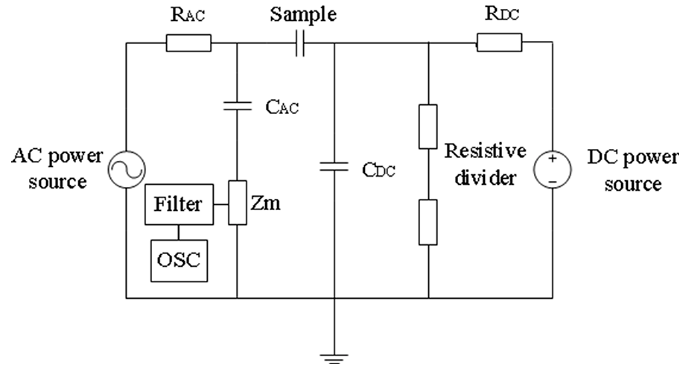
Figure 1. Schematic diagram of the experimental arrangement. Table 1. Parameters of the experimental circuit.